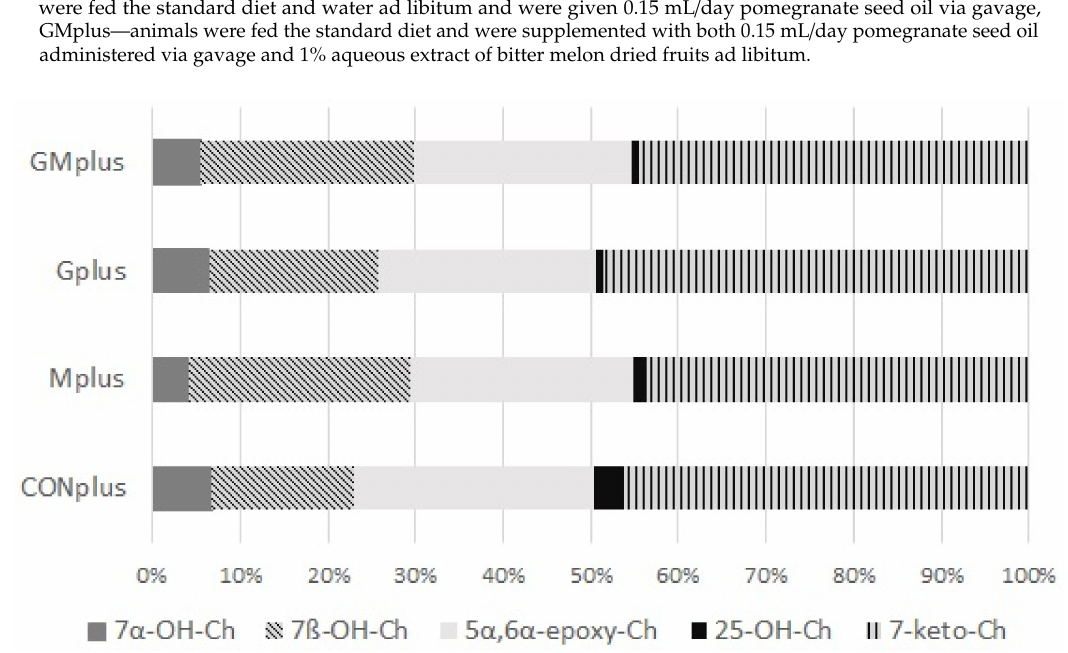
Figure 3. Oxysterols profile in mammary tumours of experimental